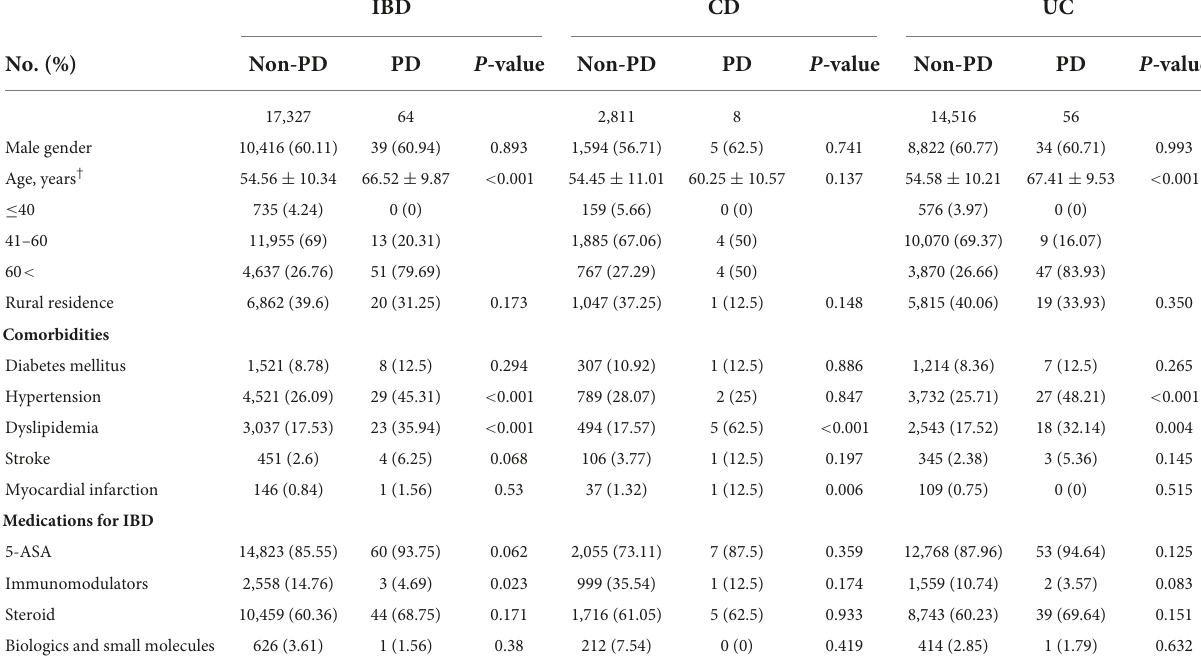
TABLE 2 Baseline characteristics of the study population in development of Parkinson’s disease on inflammatory bowel disease